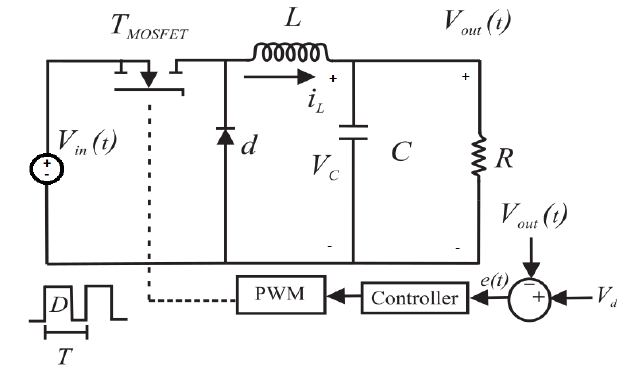
Figure 4. Buck converter with an control action (closed-loop